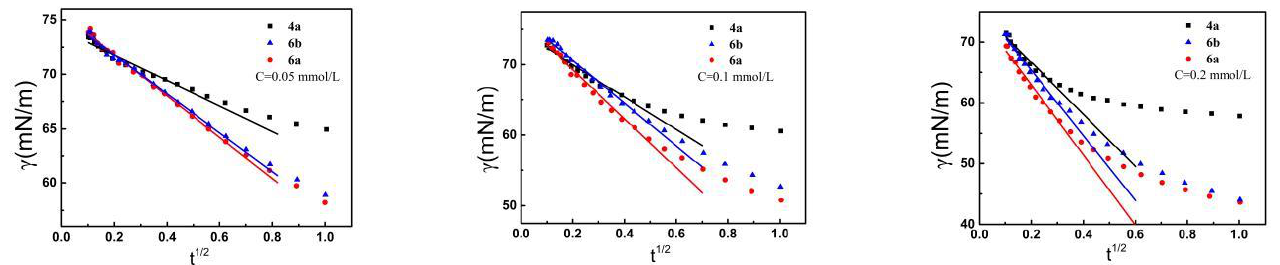
Figure 7. Linear behavior of γ ( t ) - t 1/2 determined by the short time of surfactants 4a , 6a , and 6b .